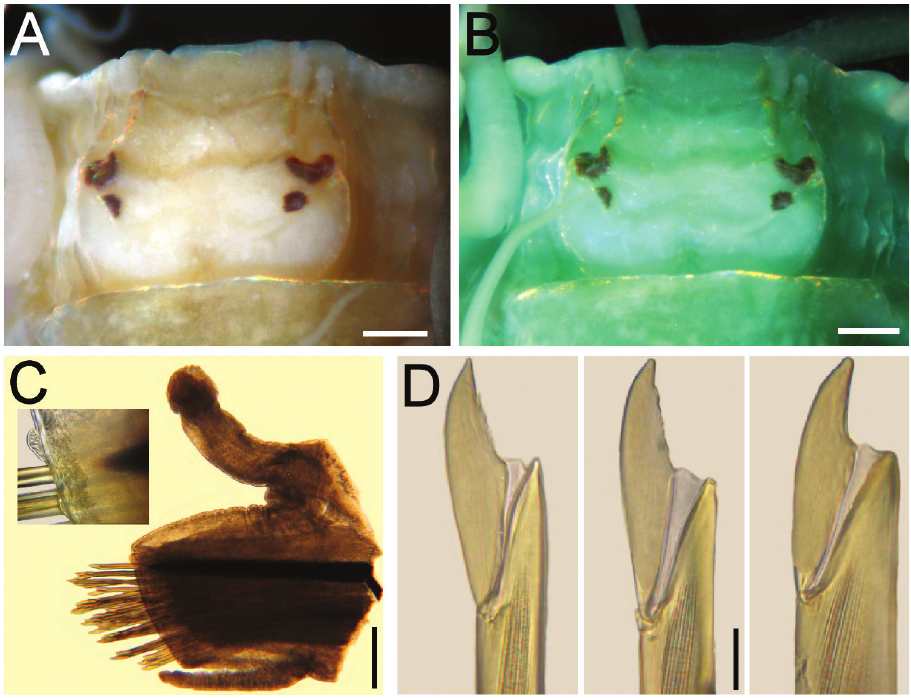
Figure 2. Elisesione mezianei sp. n. Holotype (MNHN 1777). A Prostomium, dorsal view B Same, after methyl-green staining C Chaetiger 7, right parapodium, anterior view, dorsal cirrostyle removed, only base left on cirrophore (inset: close-up showing tips of double acicular lobe) D Chaetiger 7, neurochaetal blades, variably eroded; the one on the right has a wider handle due to optical interference, not really wider than the others. Scale bars A, B 0.27 mm, C 0.3 mm, D 20 µm.